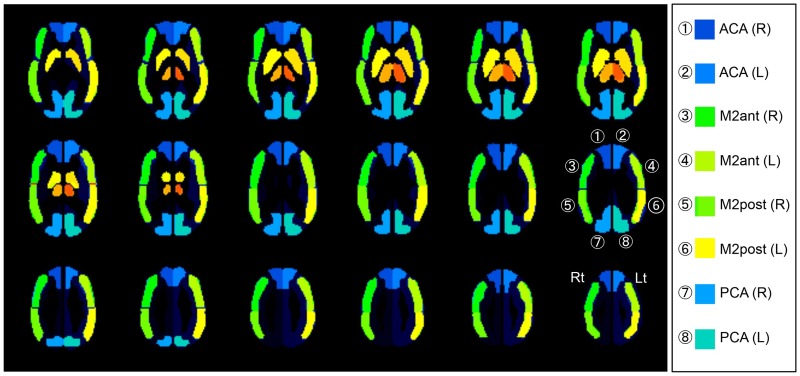
Automated ROI constitution focusing of the cerebral vascular territory using NEUROSTAT.ROIs were set to cover the major vascular regions, assuming patients with cerebral vascular disease. ACA, MCAa, MCAp, and PCA regions were generated by NEUROSTAT [33]. MCAa and MCAp are comparable to M2ant and M2post in this figure, respectively.